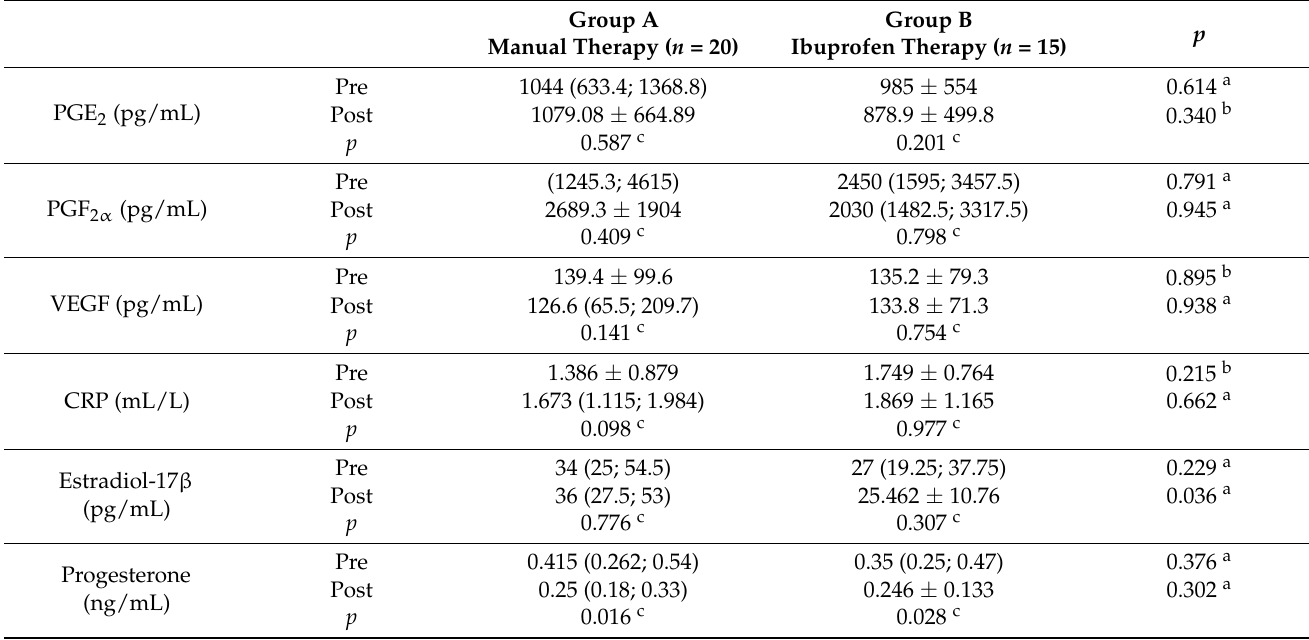
Table 2. Concentrations of prostaglandins, CRP, VEGF and sex hormones pre and post manual or